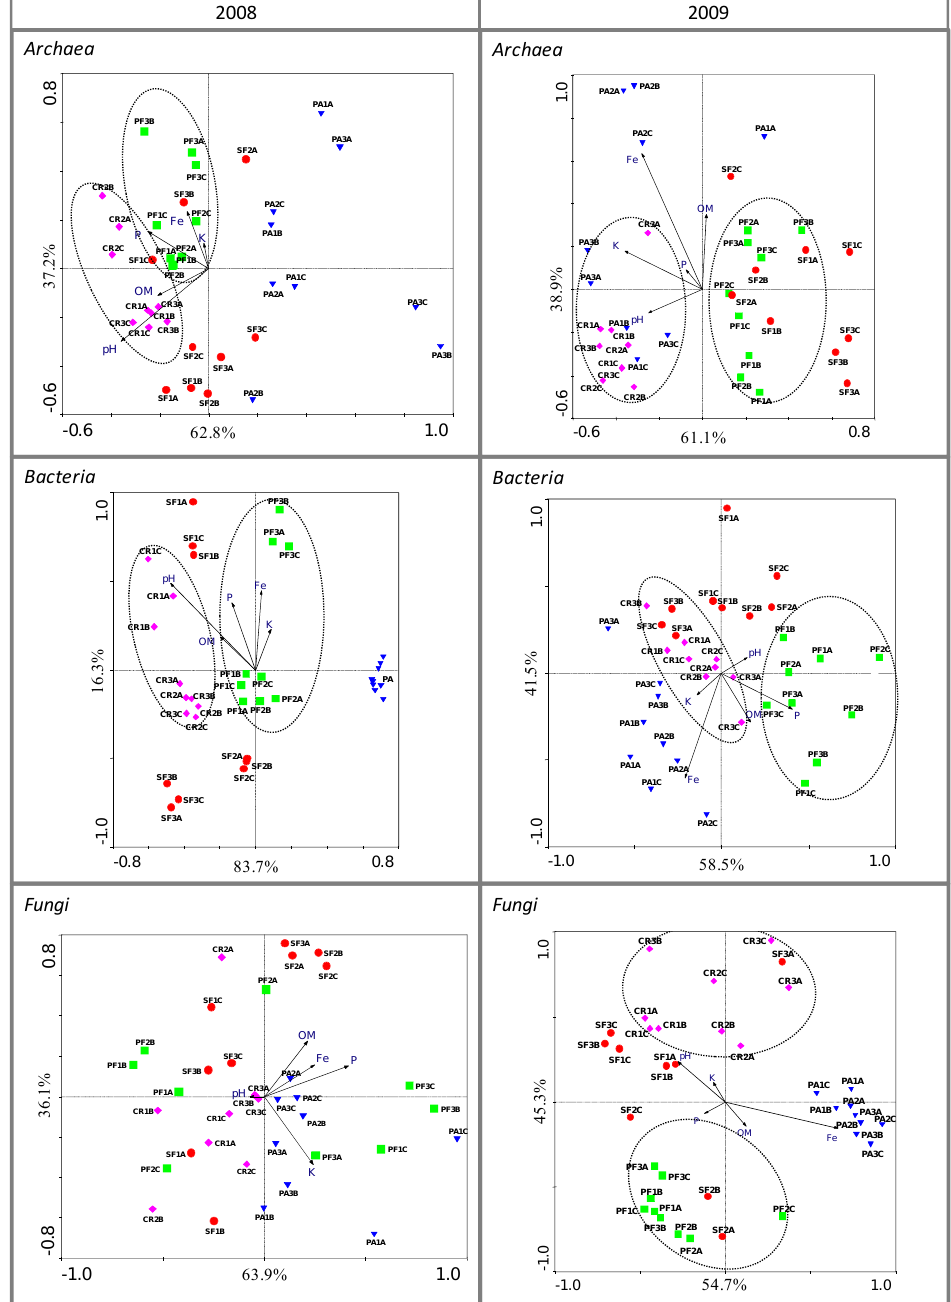
Figure 2. Non-metric multidimensional scaling (NMDS) analysis of sampling points based on the structure of soil archaeal, bacterial and fungal communities as determined by automated ribosomal intergenic spacer analysis (ARISA) and soil attributes. Samples were collected in March 2008 and January 2009. Each vector points to the direction of increase for a given variable and its length indicates the strength of the correlation between the variable and the ordination scores. The colors represent different land use systems: Primary Forest (PF, ); Secondary Forest (SF, ); Crops (CR, ); Pasture (PA, ). Each point in the ordination is identified by the abbreviation of the correspondent land use system followed by the point sampling (1, 2 and 3) and replicate PCR product analyzed (A, B and